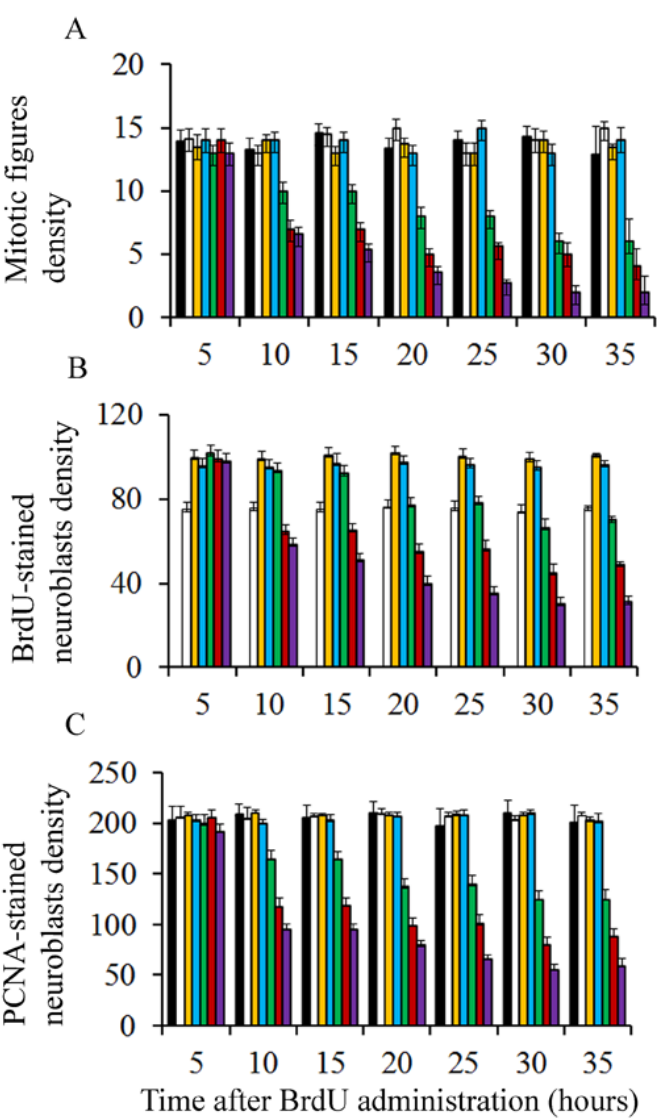
Figure 1. Mean values for mitotic figure ( A ), BrdU-reactive neuroblasts ( B ), and PCNA-stained cells density ( C ) in the cerebellar neuroepithelium of rodents injected with saline (black columns), 25 µ g/g (white columns), 50 µ g/g (yellow columns), 75 µ g/g (blue columns), 100 µ g/g (green columns), 200 µ g/g (red columns), and 300 µ g/g of BrdU (purple columns).